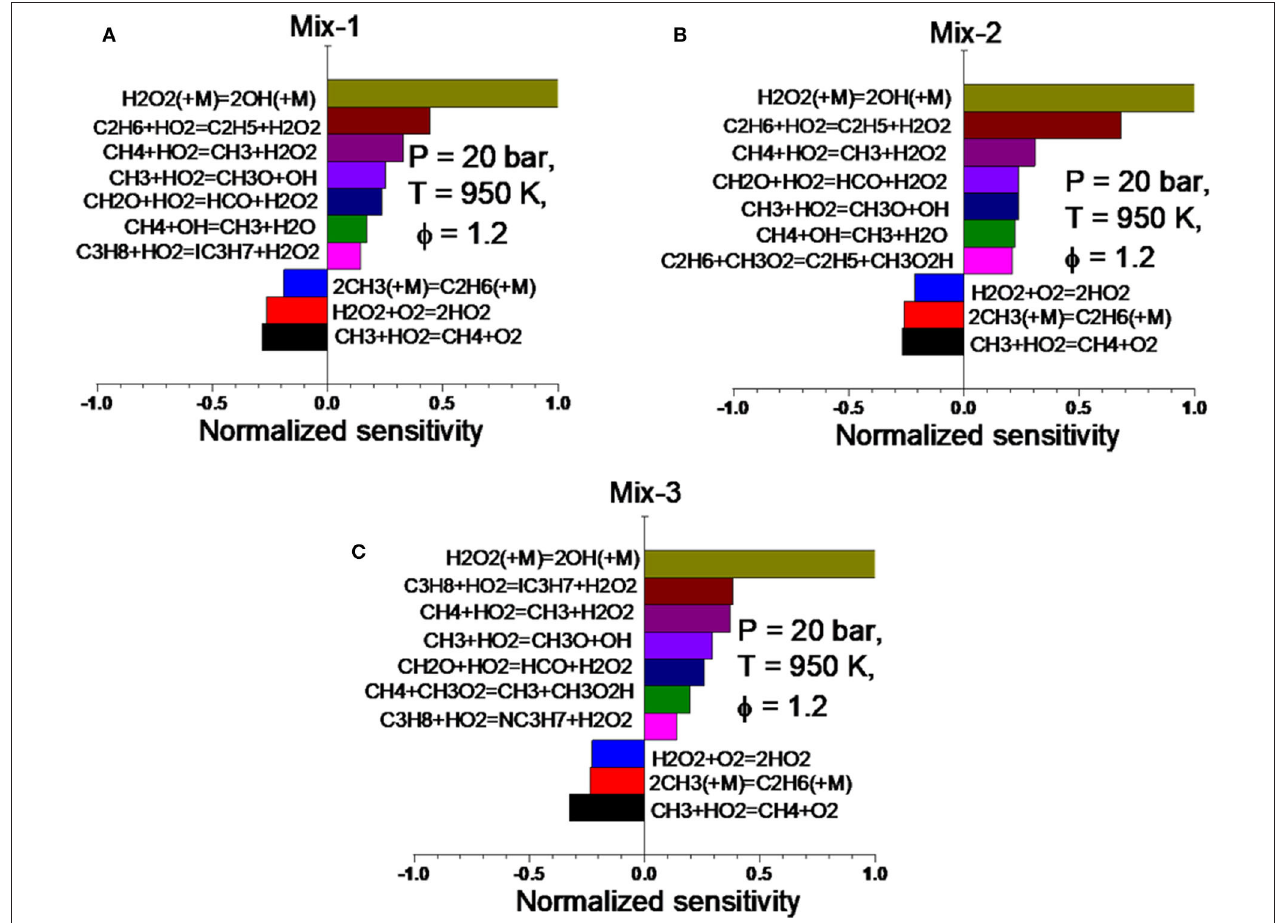
FIGURE 10 | Sensitivity analysis on the OH radical at time of ignition for Mix 1 (A) , Mix 2 (B) , and Mix 3 (C) at 20 bar, 950K, and φ = 1.2 based on the NUIG n -hexane mechanism ( Zhang et al.,